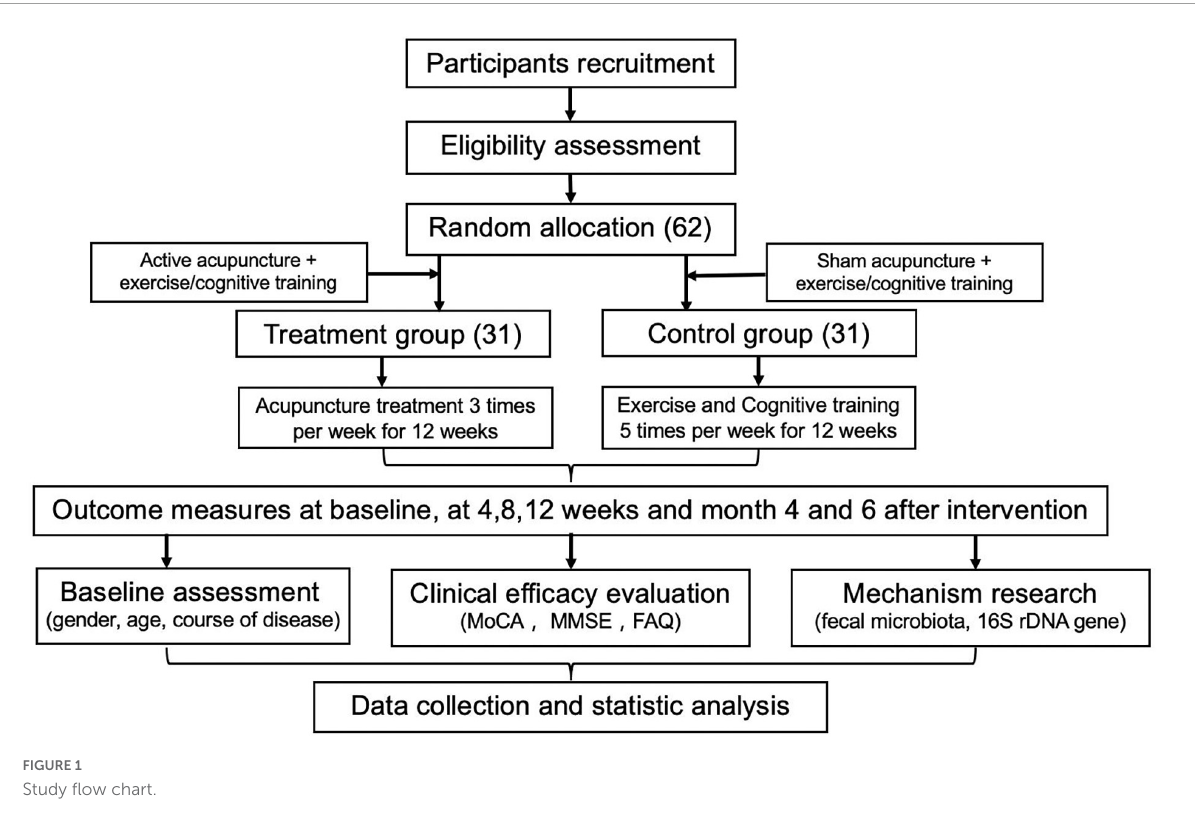
FIGURE1 Study flow chart.